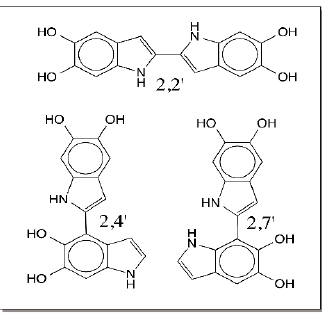
Figure 22. Structure of DHI dimers. Oxidative polymerization of DHI yields 2,2 ′ , 2,4 ′ and 2,7 ′ coupled DHI dimers as the major products.